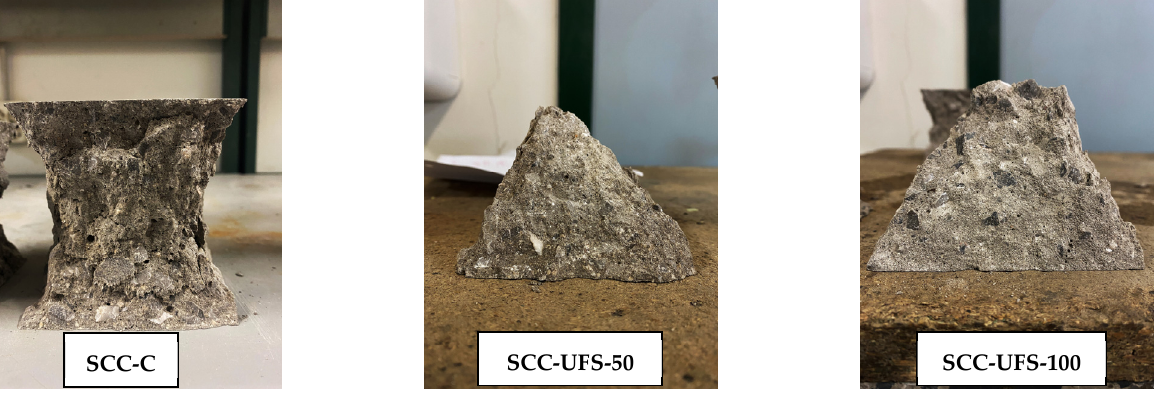
Figure 6. Detail of compression fractures at 28 days.